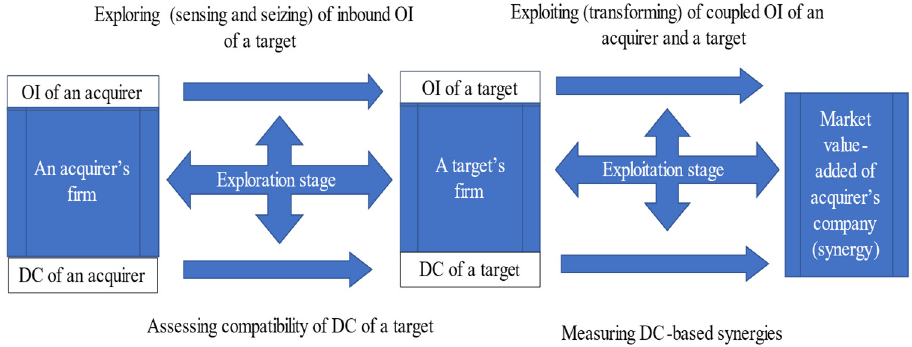
Figure 1. Conceptual illustration of the relationship among discussed research variables. Source: Developed by the author. Abbreviation: DC, dynamic capabilities.